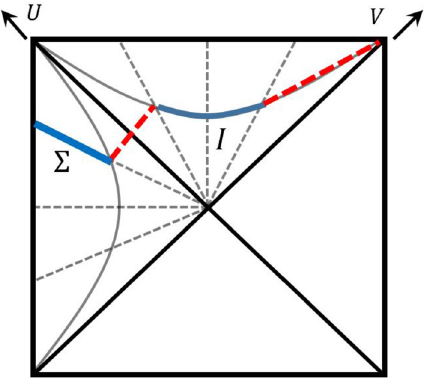
Fig. 5 Regions satisfying three conditions. We set cG ( 3 ) H /( 6 π) = 0 . 09 and G ( 3 ) H = (cid:10) UV H = 0 . 1. (Left): Constant central charge ( dc / dr = 0 ) case. Regions allowed by condition 1 and ∂ i 0 in condition 2 are colored in blue and orange, respectively. They do not overlap. While ∂ U S gen ( G ) ≤ 0 in condition 3 is not satisfied in any region, other conditions are satisfied in the